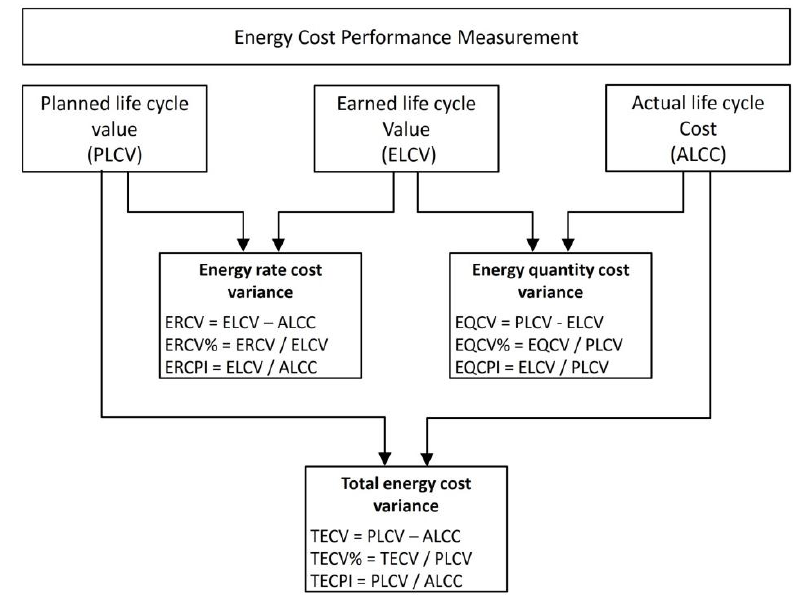
Figure 6. Actual energy cost performance indicators and metrics calculations using the earned value approach.